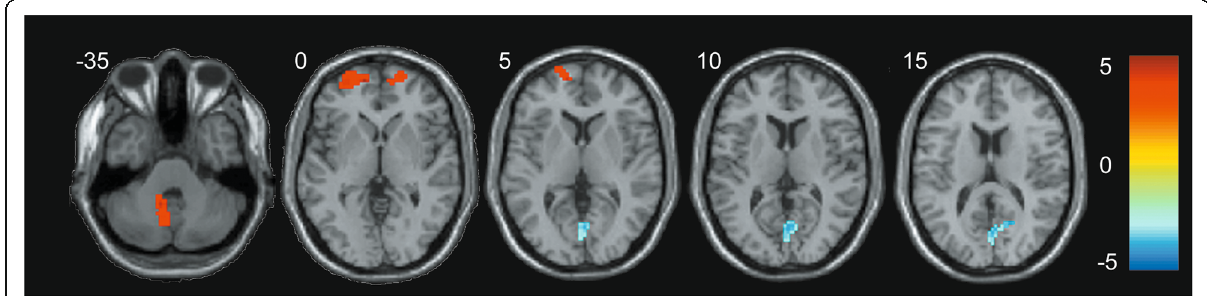
Fig. 1 Significant differences in ALFF between the CADASIL and control groups. The CADASIL group showed significantly lower ALFF values in the right Pcu/CU (in blue), and higher ALFF values in the bilateral SFG and left cerebellar anterior and posterior lobes (in red) compared with controls. The color-coded scale was referred to the t-values. ALFF: amplitude of low-frequency fluctuation; CADASIL: cerebral autosomal dominant arteriopathy with subcortical infarcts and leukoencephalopathy; Pcu/CU: precuneus and cuneus; SFG: superior frontal